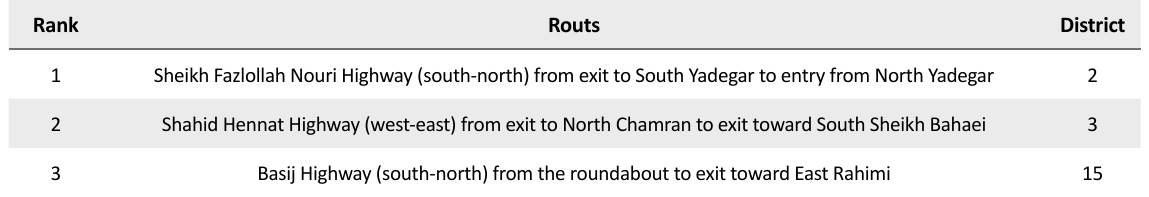
Table 1. Top three traffic-prone districts of Tehran metropolis [21]